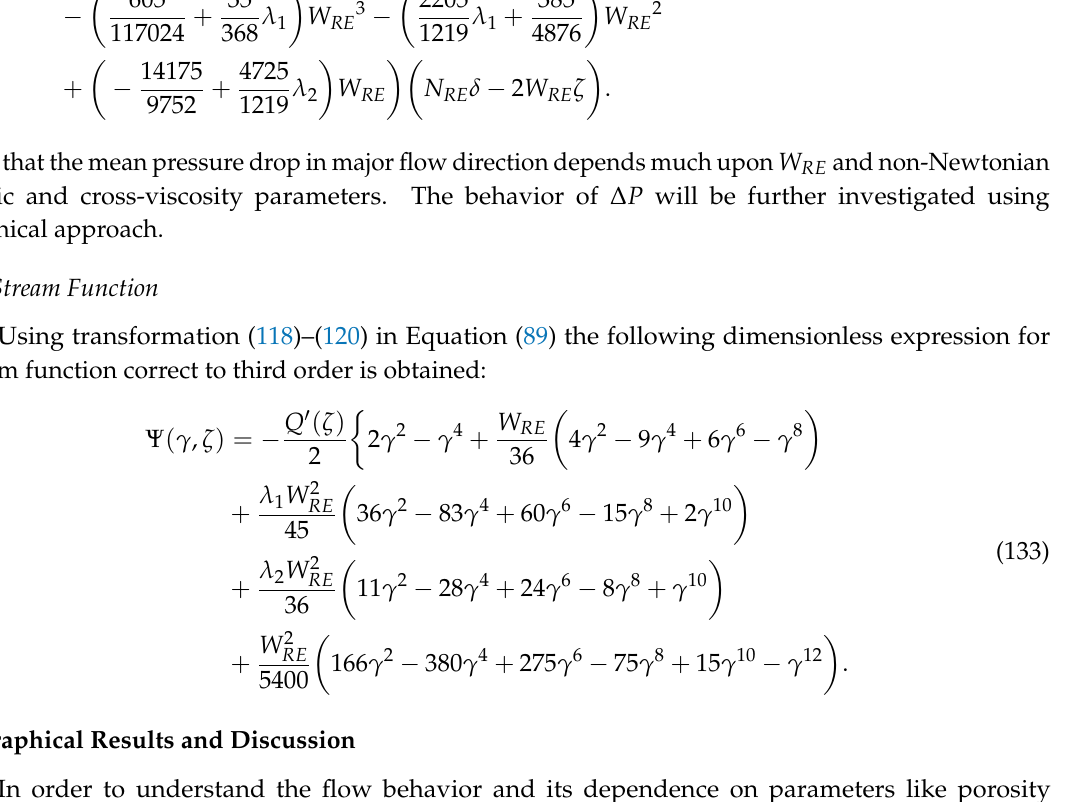
Table 1. Using these values it is found that δ = 1.6 × 10 − 3 and N RE = 3.2 × 10 − 2 . Inequality (126) can now be used to set a range of values for wall Reynolds number W RE so that to avoid any reverse flow. One can easily find that W RE ≤ 1.28 × 10 − 5 . On the basis of this analysis set W RE ∈ [ 0.5, 1.5 ] × 10 − 5 for graphical representation. The values of elastic parameter α 1 and cross-viscosity α 2 are assumed to be of the order 10 − 1 , therefore values of dimensionless elastic parameter λ 1 and cross-viscosity parameter λ 2 are taken in the range [ 0.2, 1.2 ] × 10 6